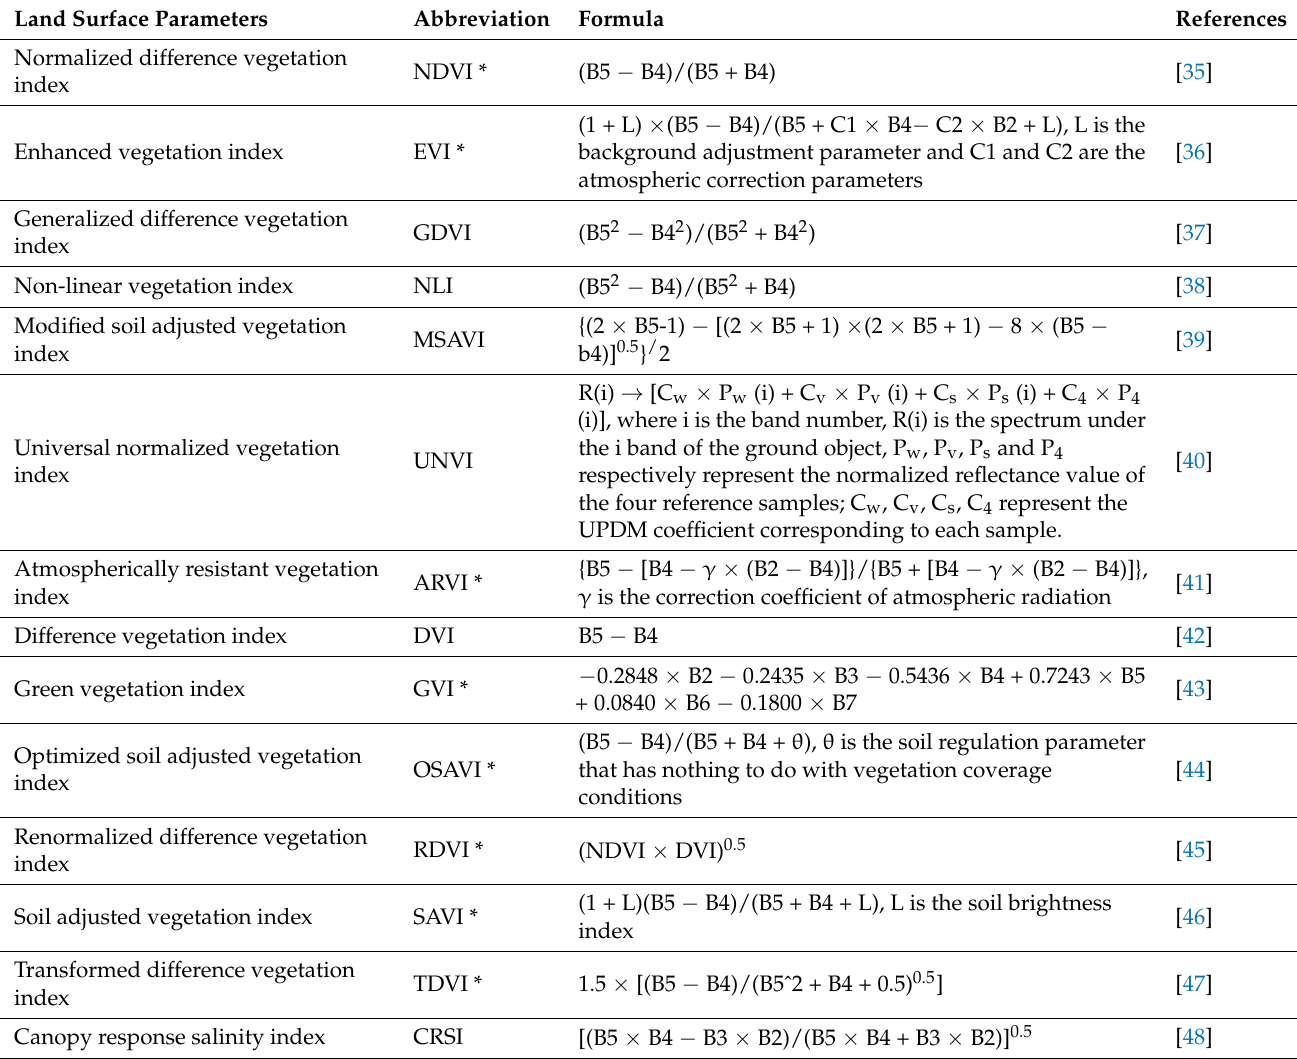
Table 2. Vegetation indexes required for the